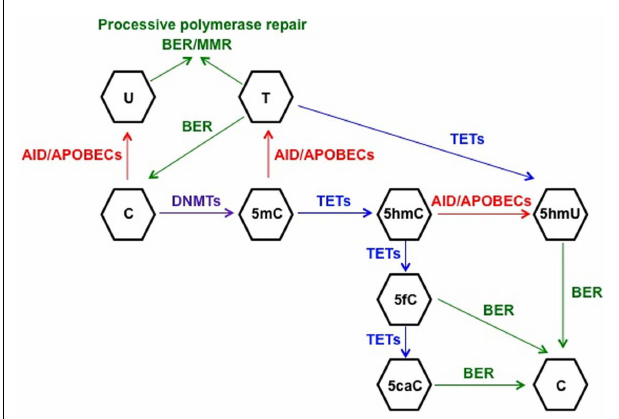
FIGURE 1 | Schematic representation of the proposed mechanisms for active DNA demethylation . DNMTs catalyze the methylation of cytosine (C) to 5-methyl-C (5mC), which can be deaminated to thymine (T) by AID. The generated mismatch can be repaired by the short-patch BER machinery, restoring C, or by one of the processive repair pathways (long-patch BER or MMR), leading to demethylation of a fragment of DNA. This machinery involving processive DNA polymerases can also repair the uracil:guanine (dU:dG) mismatches generated after C deamination to U. On the other hand,TET-mediated hydroxylation of 5mC generates 5-hydroxymethyl-C (5hmC), which can be deaminated by AID/APOBECs to 5-hydroxymethyl-U (5hmU) and replaced by C through BER. 5hmC can be further oxidized byTETs proteins to 5-formyl-C (5fC) and 5-carboxyl-C (5caC), leading to activation of BER to restore C. Finally, another potential mechanism of active DNA demethylation would involve 5mC deamination toT andTET-mediated oxidation ofT to 5hmU, which would be replaced by C through BER, although this model has not been proven as